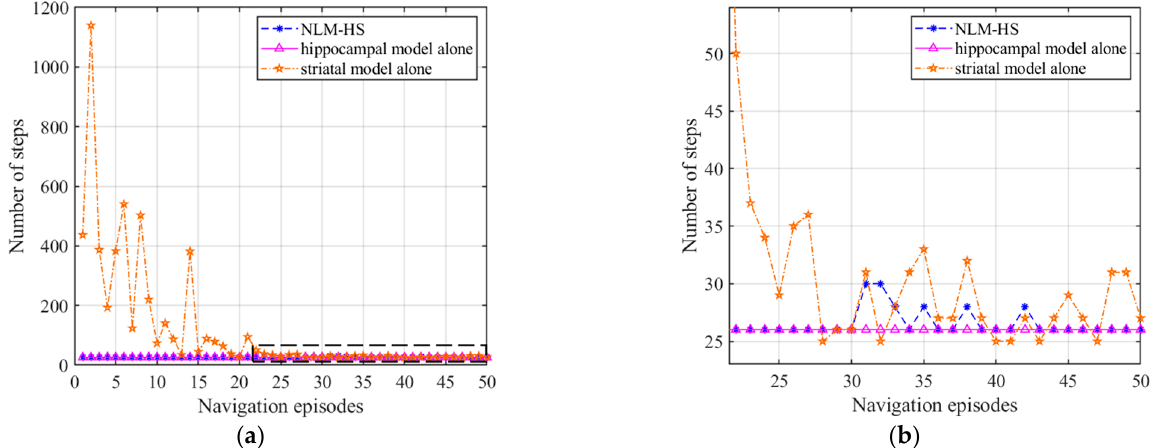
Figure 24. Comparison of navigation steps of the three models. ( a ) Comparison of navigation steps; ( b ) Enlarged version of the dotted box in ( a ).